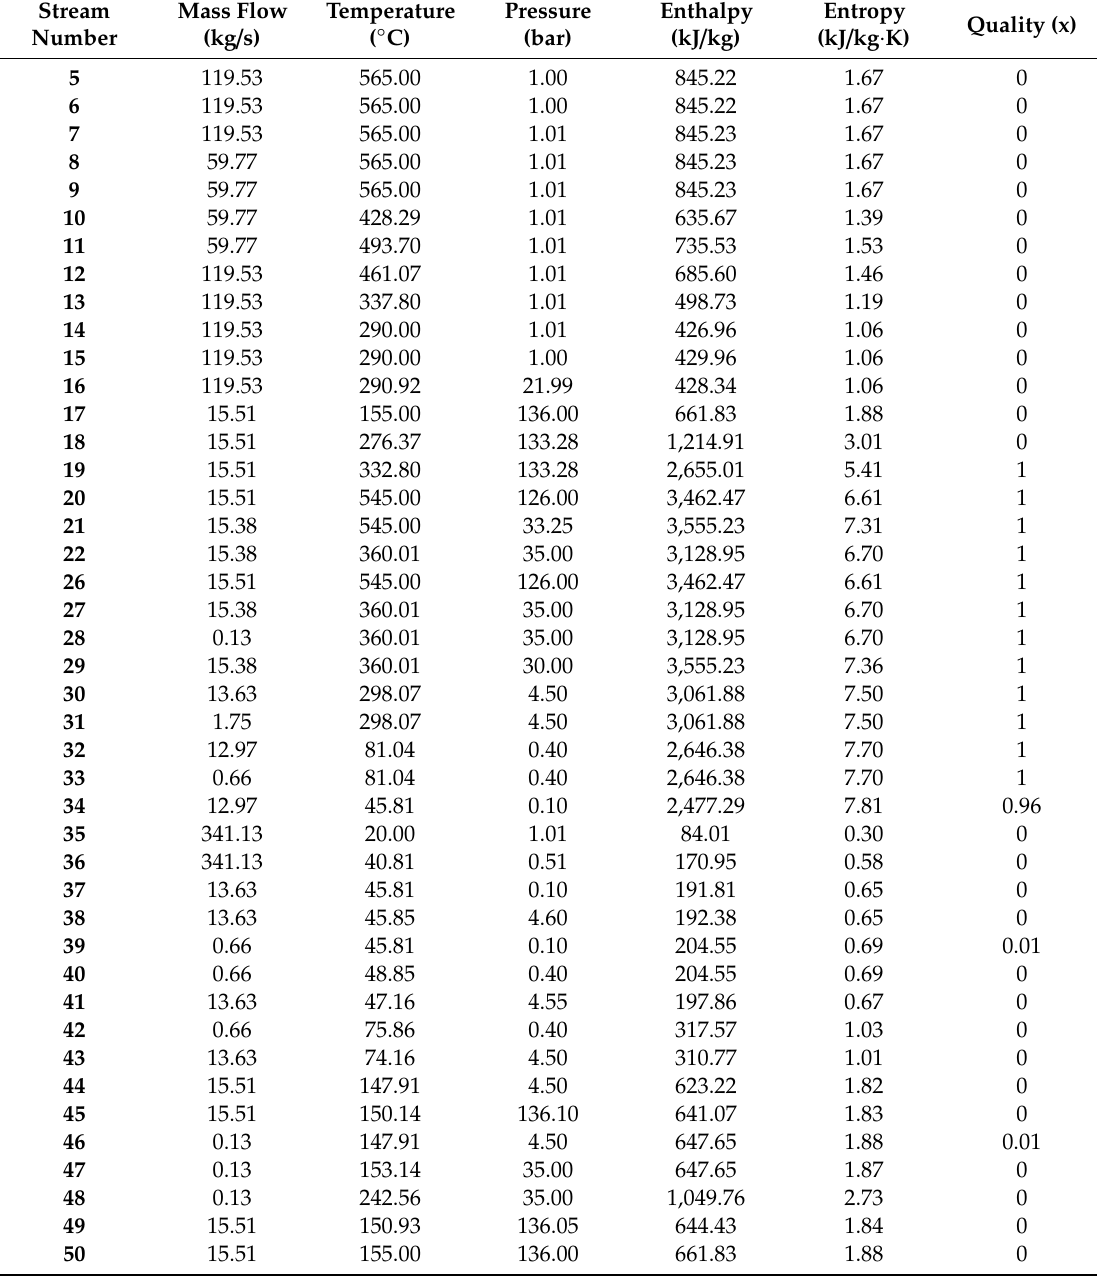
Table A1. Solar plant stream